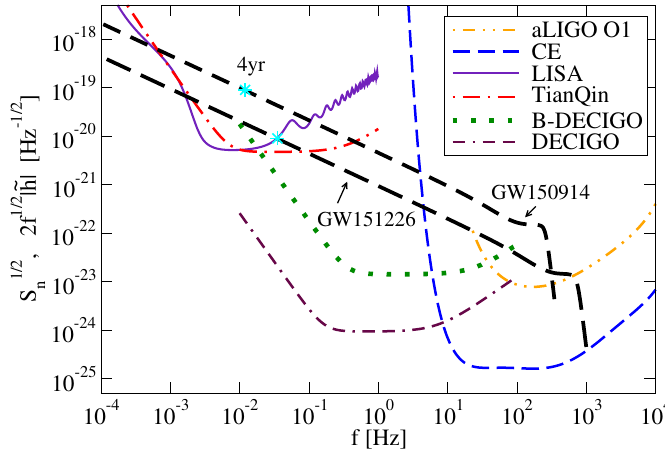
(cid:112) S n ( f ) of the gravitational-wave interferometers Figure 3. The (square root of) spectral noise densities (cid:112) f | ˜ h ( f ) | for both events GW150914 and discussed in this document. The characteristic amplitudes 2 GW151226 are also displayed, with four years prior to merger shown as cyan stars. The ratio between (cid:112) (cid:112) f | ˜ h ( f ) | and S n ( f ) roughly corresponds to the signal-to-noise-ratio (SNR) of the event. Observe 2 how the early inspiral portions of the BH coalescences are observed by the space-based detectors, while the late inspiral and merger-ringdown portions are observed by the ground-based detectors. This figure is taken and edited from